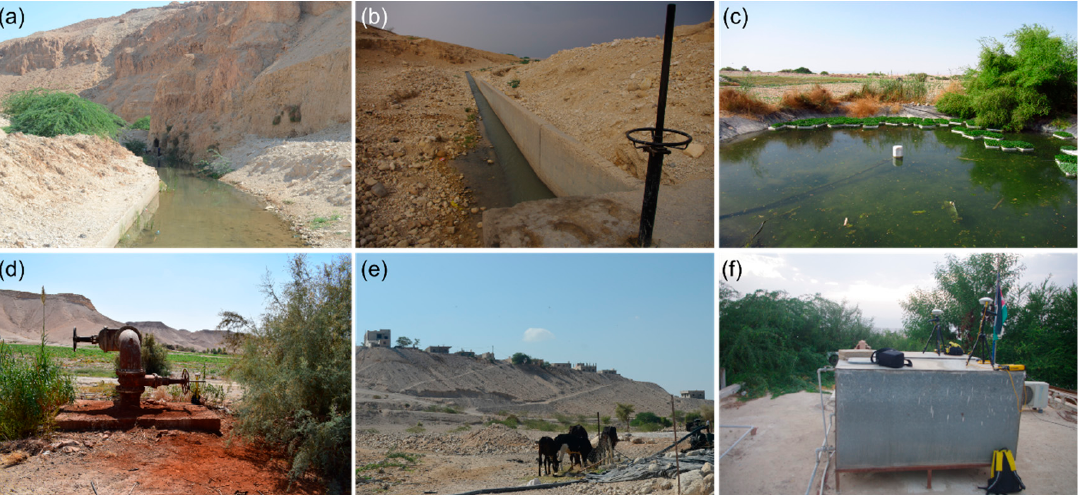
Figure 5. Water supply at Ghor Al ‐ Haditha. ( a ) Ain Maghara spring with ( b ) connected channel system that leads water towards the irrigation area, where it is partly stored in ponds ( c ). ( d , e ) are typical pumping wells for this area despite the substantial groundwater level decline. ( f ) Drinking water is stored in tanks. Photos ( a , d , e ) were taken by Robert Alban Watson; photos ( b , c , f ) by Djamil Al ‐ Halbouni.